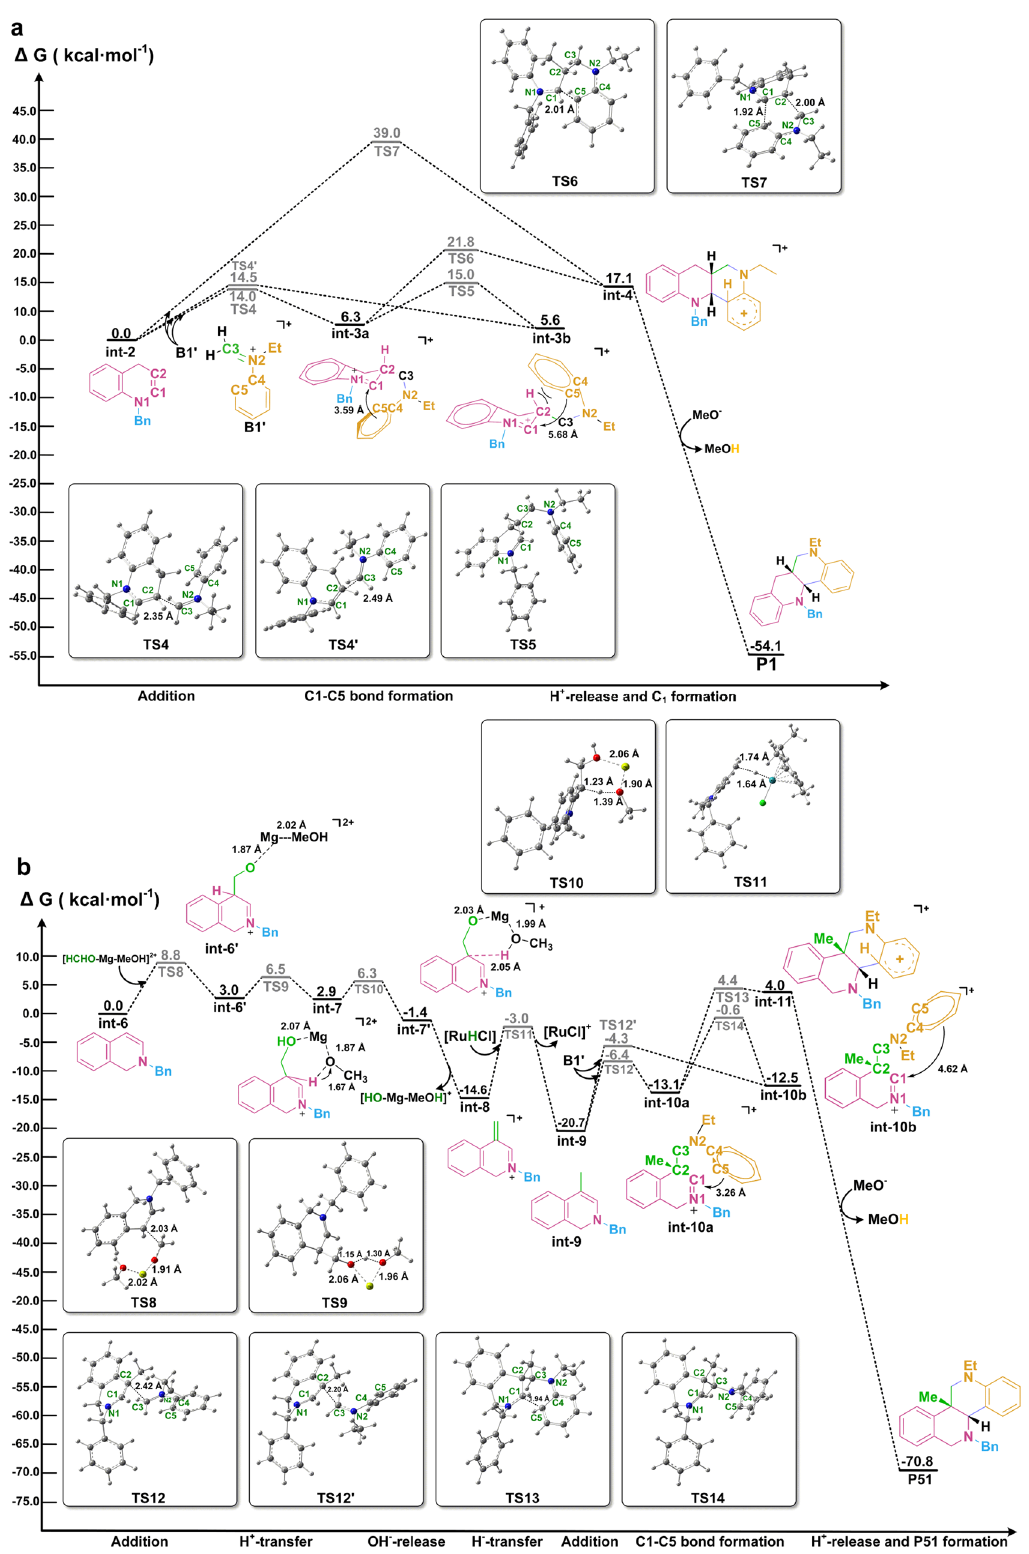
Fig. 8 DFT studies (free energies in kcal mol − 1 ). a Potential energy surfaces for the process from int-2 to P1 . b Potential energy surfaces for the process from int-6 to P51